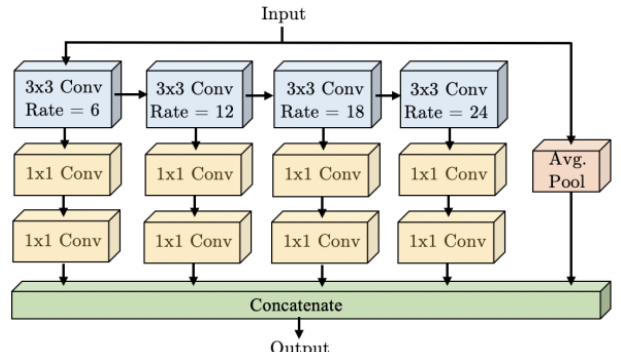
Figure 2. Waterfall Atrous Spatial Pooling (WASP) module